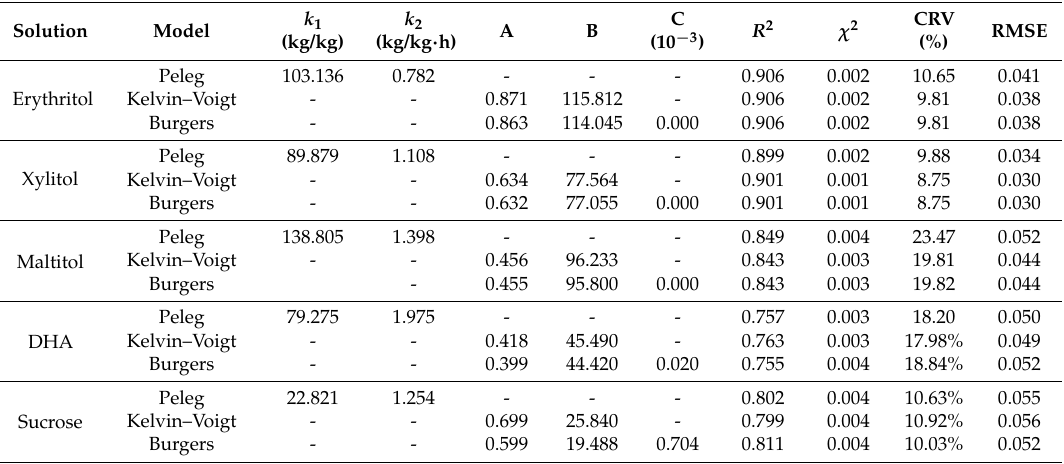
Table 6. The values of k 1 , k 2 , R 2 , χ 2 , CRV and RMSE of modeling solids gain ( SG ), using Peleg’s, Kelvin–Voigt and Burgers